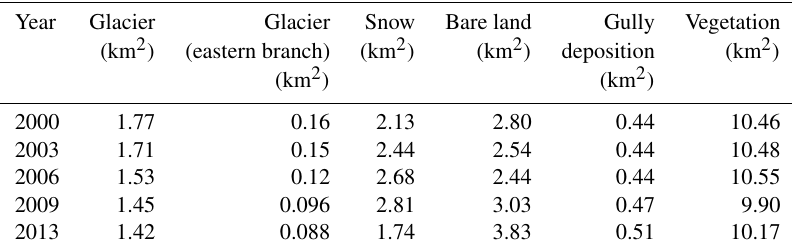
Table 1. Changes in glacier, snow, bare land, gully deposition and vegetation in Tianmo Valley.